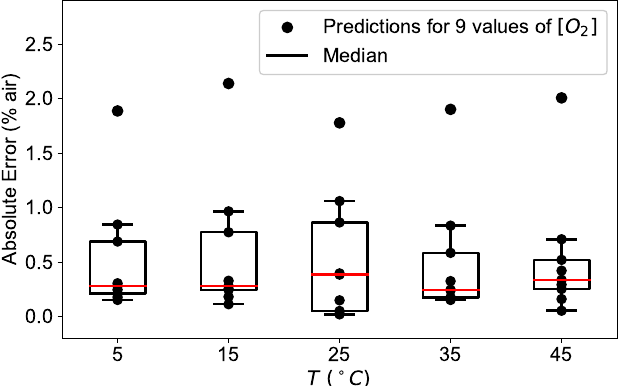
Figure 11. Absolute error (AE) distribution of the neural network model prediction applied to the experimental data for different concentrations calculated at the temperatures of 5 ◦ C, 15 ◦ C, 25 ◦ C, 35 ◦ C, and 45 ◦ C for a network with 3 layers and 10